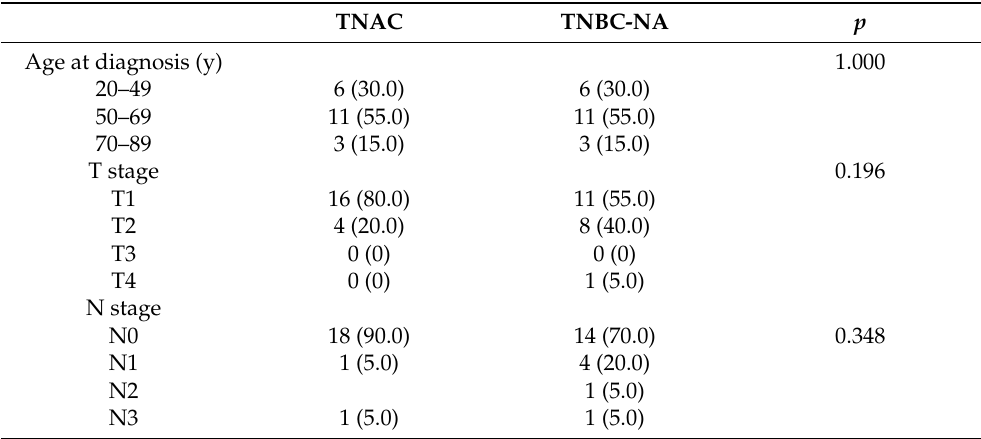
Figure 1. Representative HE and IHC staining images from TNAC and TNBC-NA patients. Scale bar indicates 50 μ m. Table 1. Clinicopathological features of TNAC and TNBC-NA patients who did not receive neoadju- vant